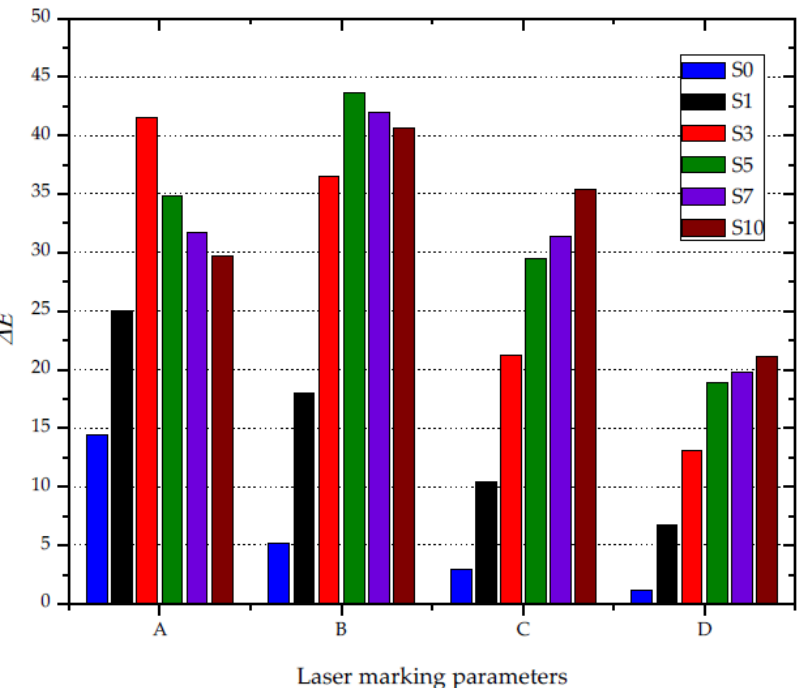
Figure 12. The impact of the content of silica waste and the laser operating parameters on the Δ E parameter .